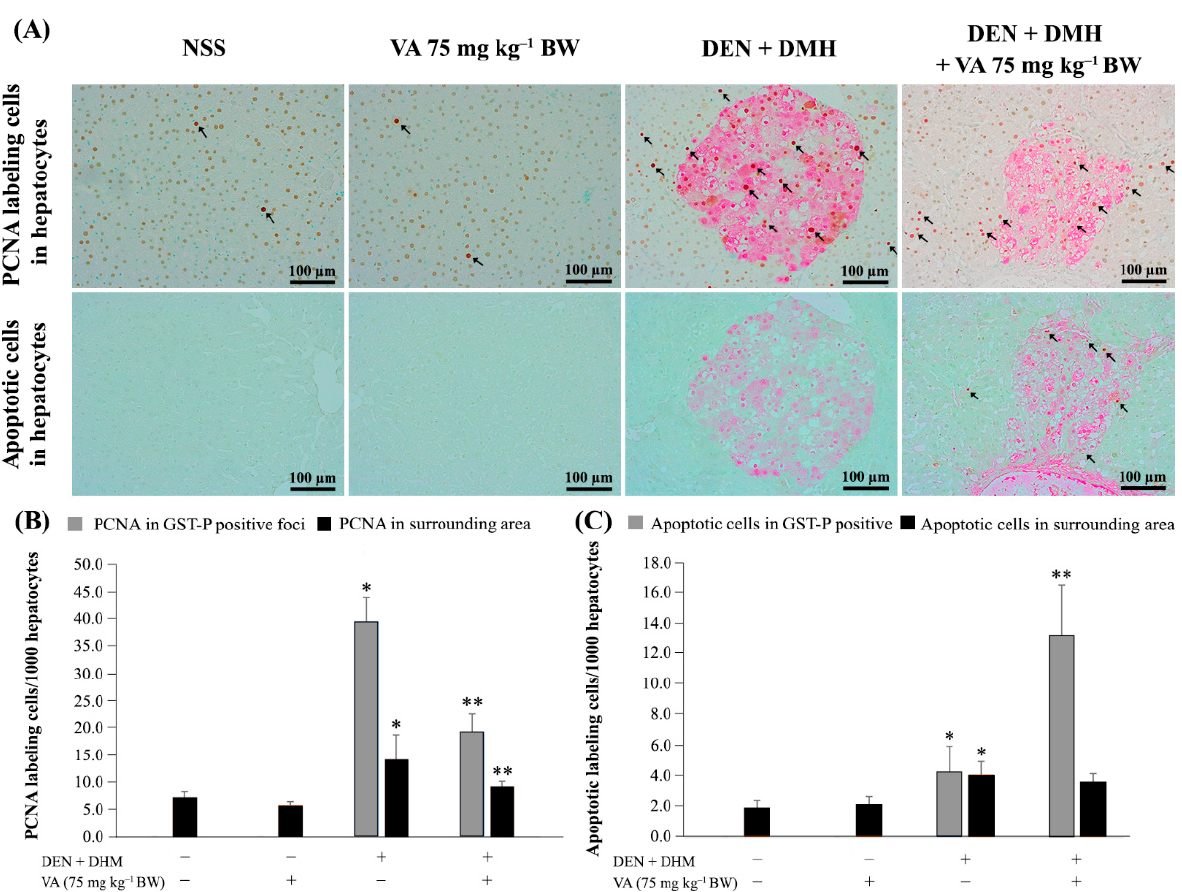
Figure 2. The effect of vanillic acid on cell proliferation and apoptosis. ( A ) Double-staining immunohistochemistry of PCNA positive cells and apoptotic cells in hepatocytes (20 × ). Arrowheads, stained hepatocytes. ( B ) The number of PCNA labelling cells/1000 hepatocytes ( C ) The number of apoptotic cells/1000 hepatocytes. The values are expressed as mean ± SD. * Significantly different from negative control group, p < 0.05. ** Significantly different from positive control group, p < 0.05. GST-P: glutathione S -transferase placental form, PCNA: proliferating cell nuclear antigen, DEN: